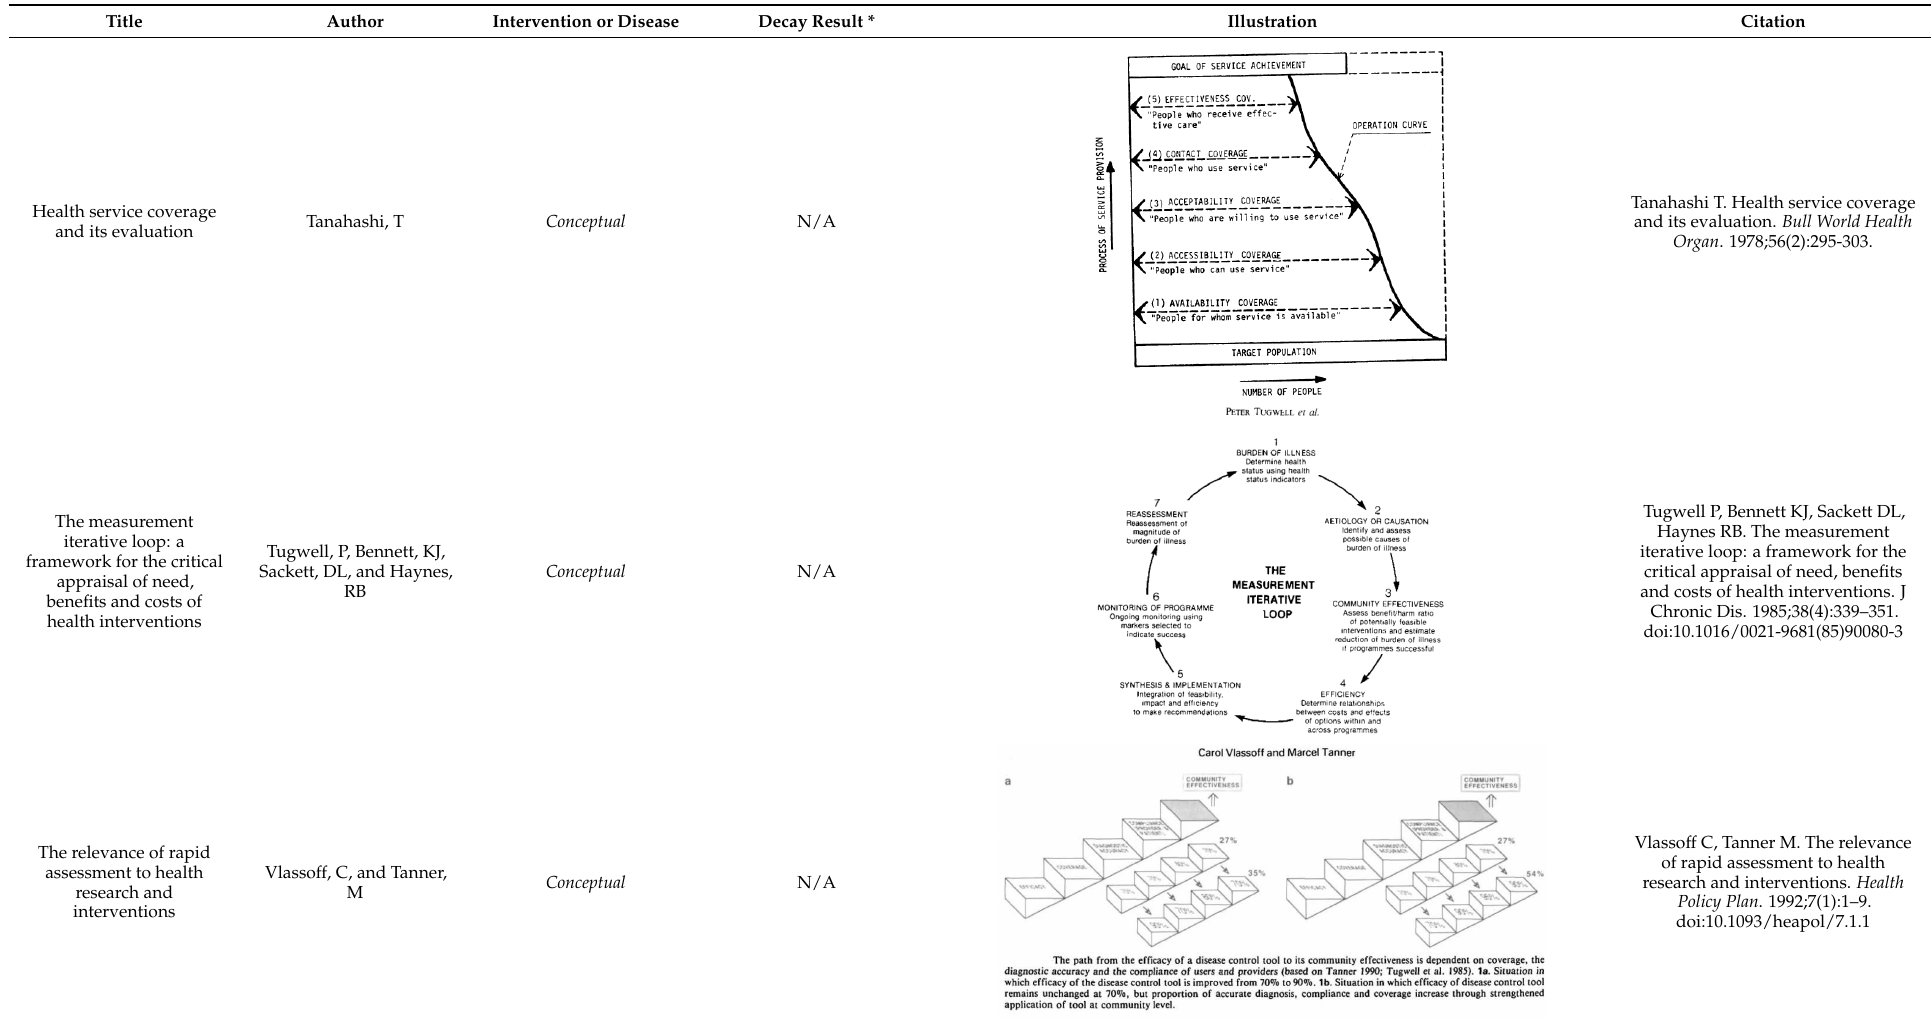
Table A1. Select Milestone Papers and Examples of the Evolution of Effective Coverage Concepts.